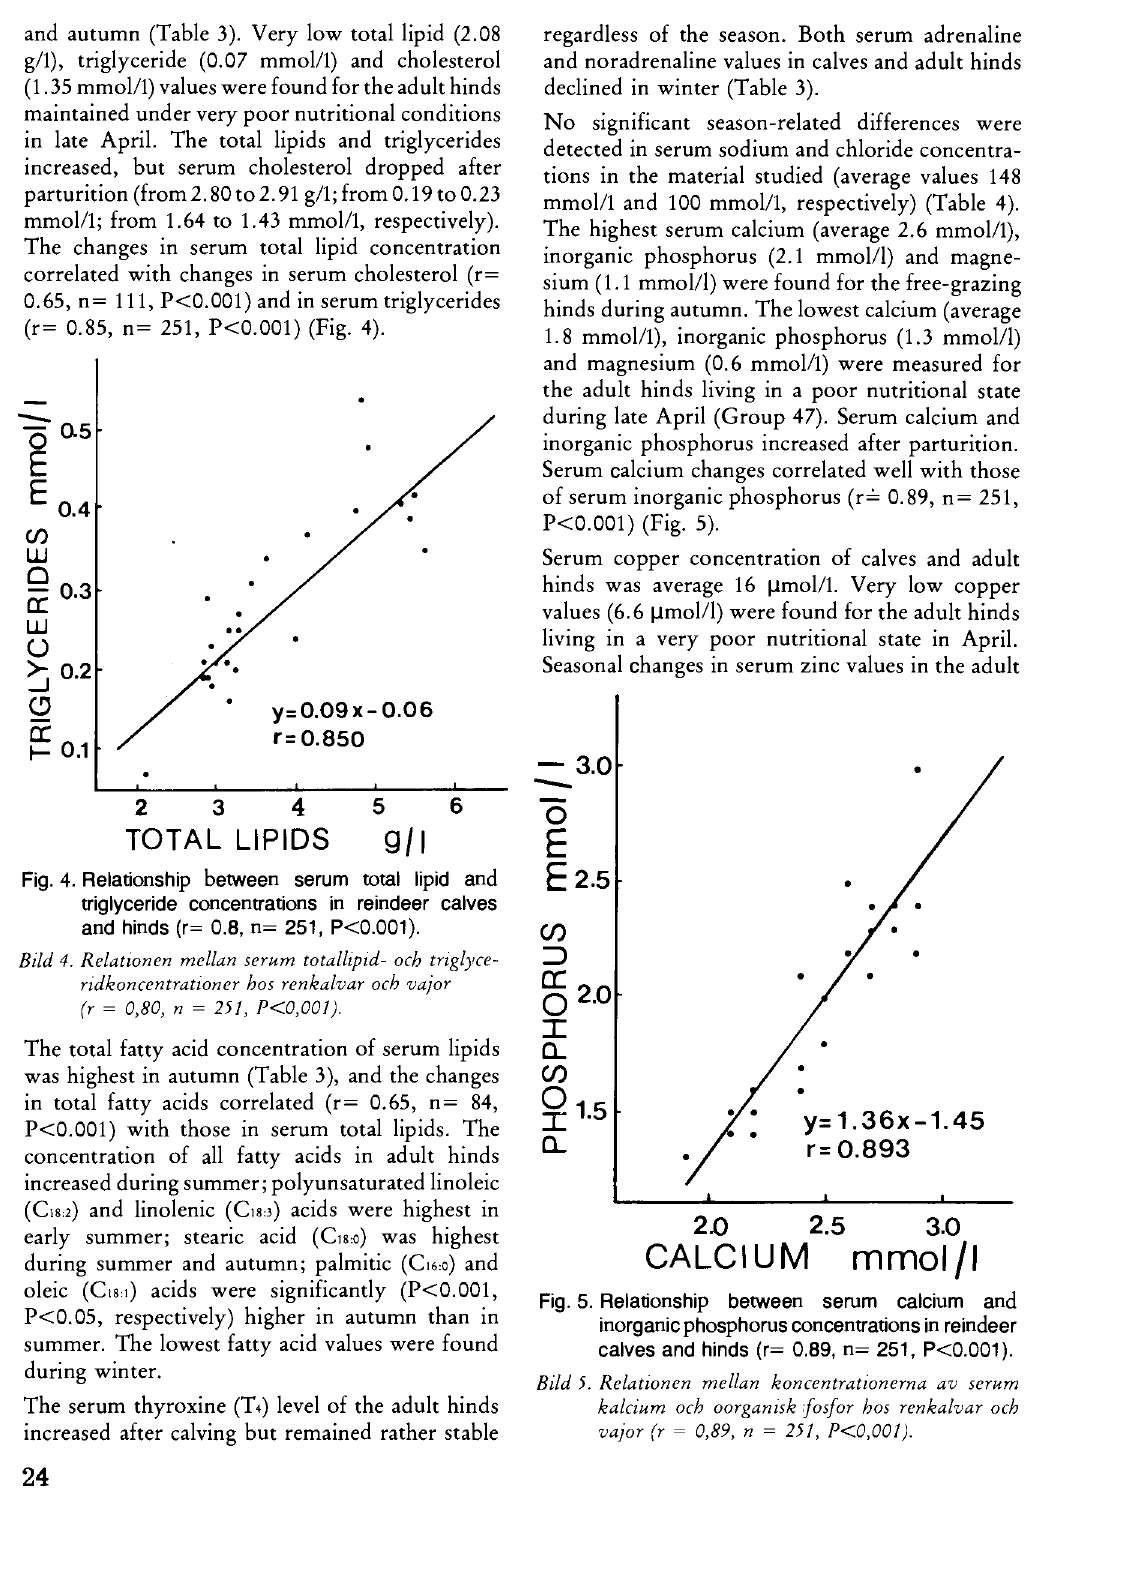
Fig. 5. Relationship between serum calcium and inorganic phosphorus concentrations in reindeer calves and hinds (r= 0.89, n= 251,